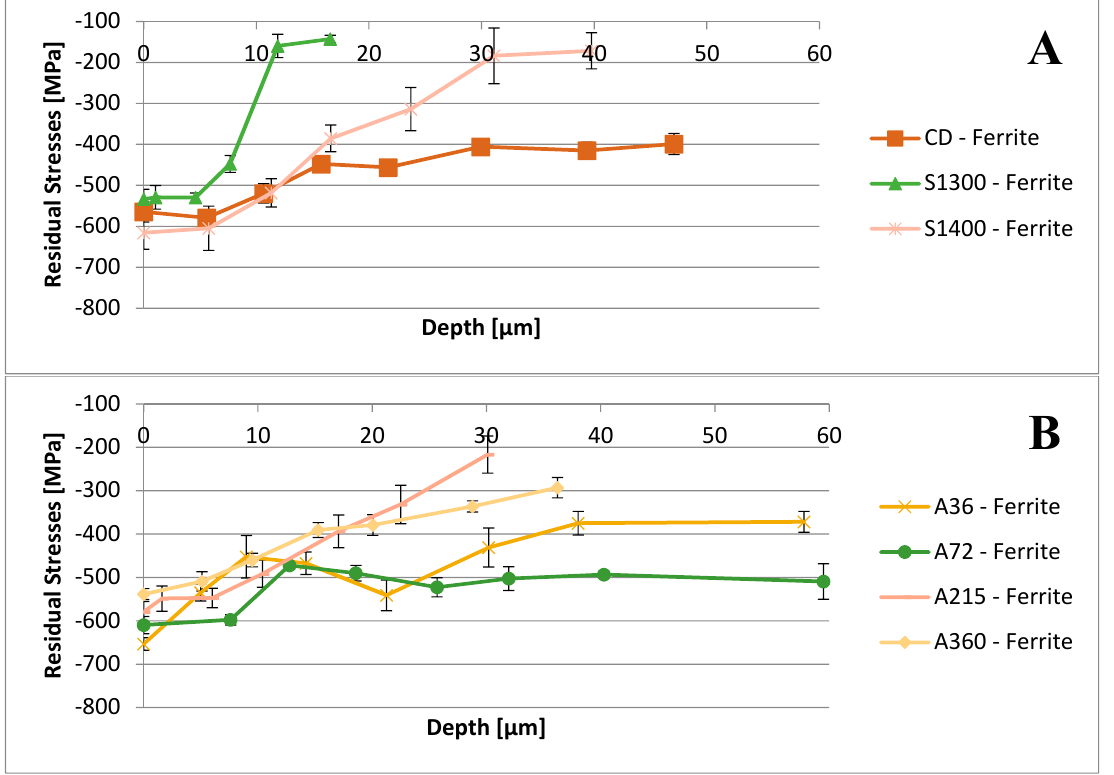
Figure 2. Depth profiles of the residual stresses induced by shot peening treatment within the ferritic phase: CD, S1300, S1400 samples ( A ) and A36, A72, A215, A360 ( B ).